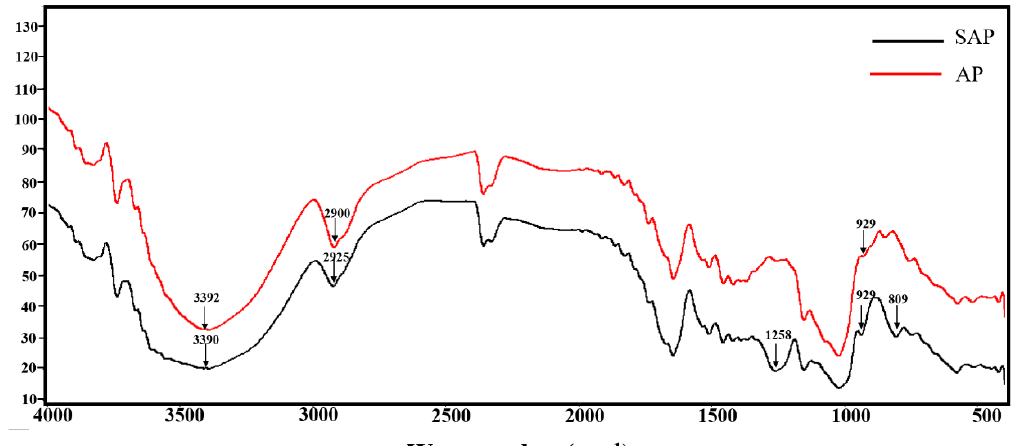
Figure 6. FTIR spectra of AP and SAP.